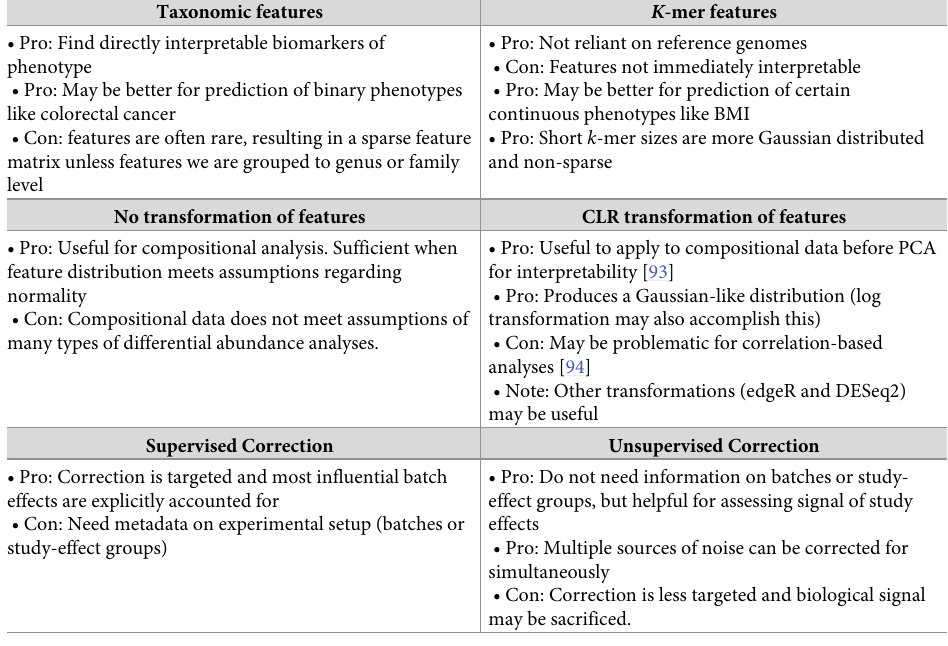
Table 2. Key considerations when performing background noise correction in metagenomic